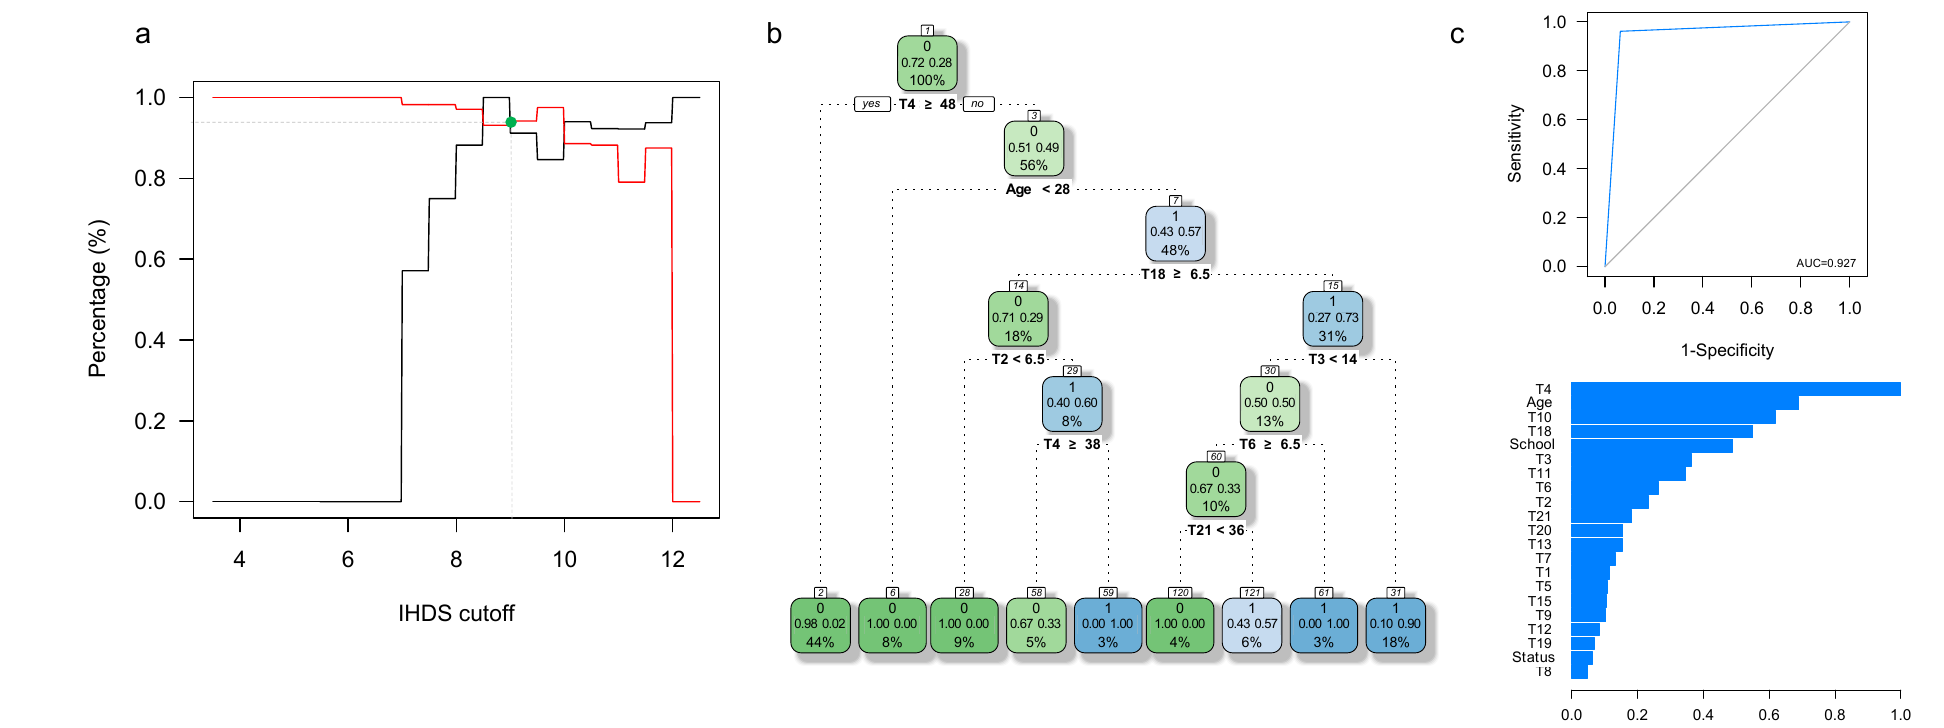
Figure 4. ( a ) Sensitivity ( S e ; black line) and specificity ( S p ; red line) as a function of the cut-off value for the IHDS in this Caribbean community. The optimal cut-off point is shown in green. ( b ) The ARPA-based predictive model for HAND when the IHDS optimal cut-off value is used to define HAND in all 120 assessed individuals. ( c ) ROC curve and variable importance for the derived model. Other conventions as in Figure